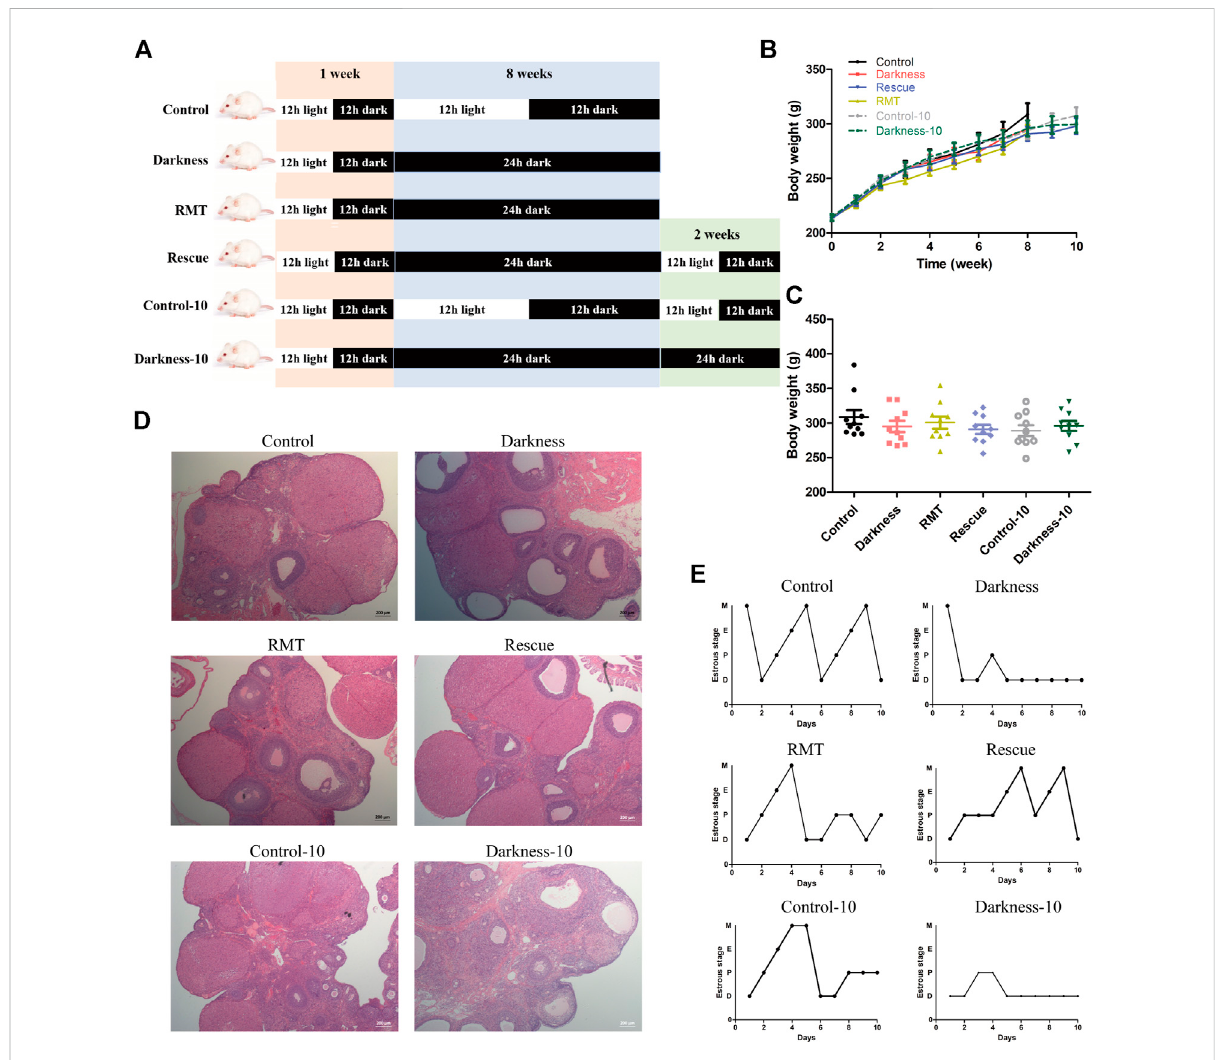
FIGURE 5 Effects of RMT and circadian rhythm restoration in constant darkness induced-PCOS rats. (A) Diagram of the experimental design. (B,C) Body weight of rats during the experimental progression. (D) Representative examples of ovarian HE-stain histology of each group of rats. (E) Representative estrous cycles of each group of rats. N = 10/group. Values are expressed as means ± SEM. Scale bar: 200 μ m. RMT,